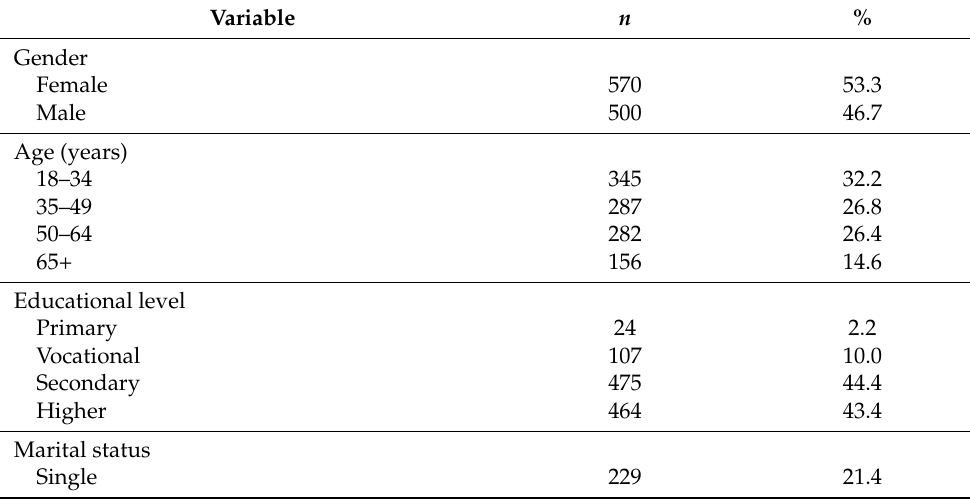
Table 1. Characteristics of the study population ( n =